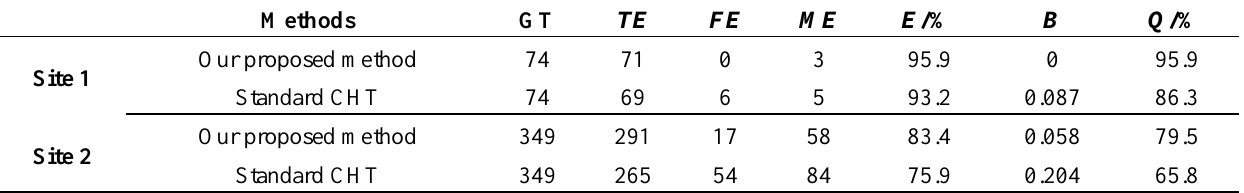
Table 1. Standard quantitative quality assessment of automated TQS extraction